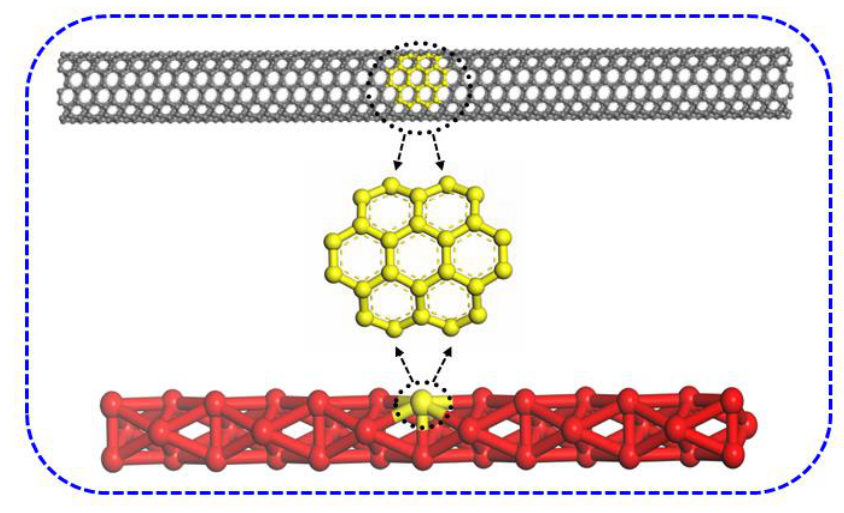
Figure 1. The coarse-grained model of SWCNTs Figure. 1 The coarse-grained model of SWCNTs (6,6).